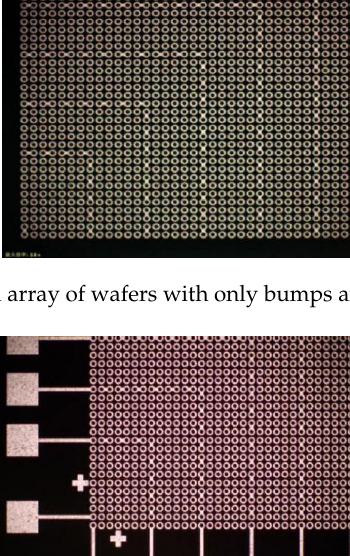
Figure 5. Partial array of wafers with only bumps and daisy chains.